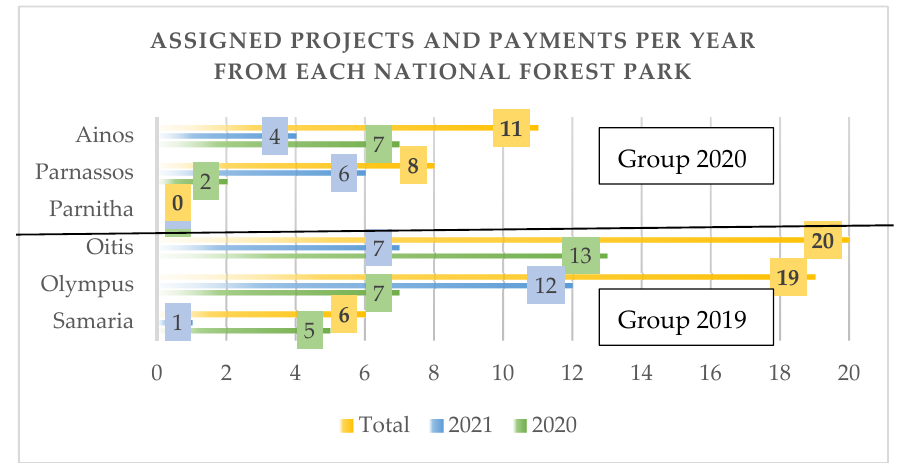
Figure 2. Assigned projects and payments per year for each NFP.